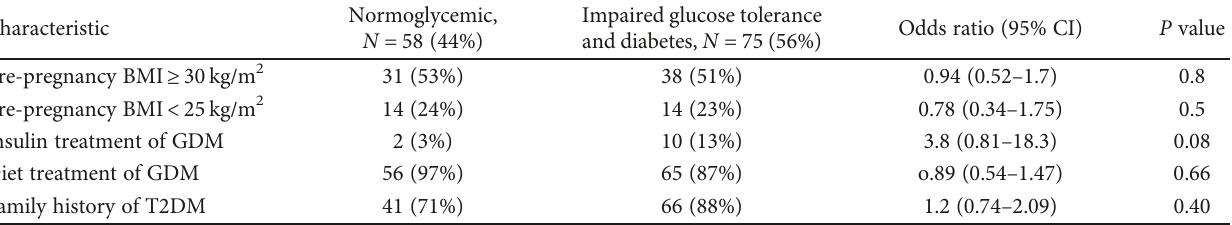
Table 2: Risk factors associated with the development of impaired glucose tolerance and diabetes in women with previous gestational